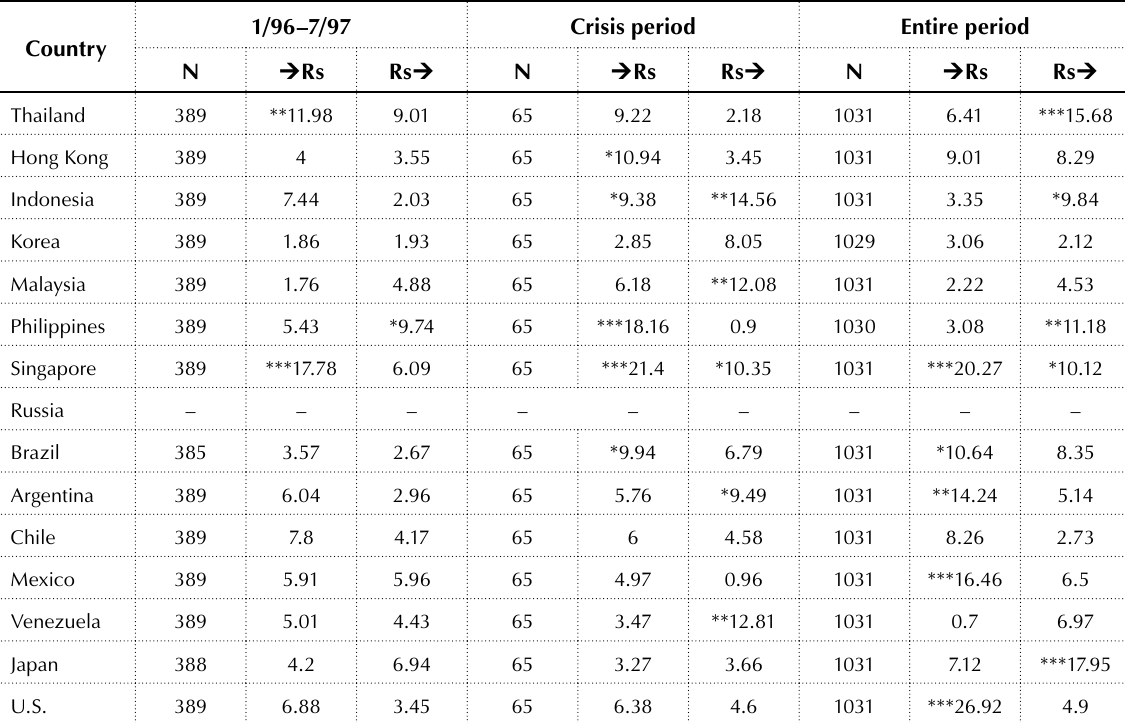
Table 4 . Liquidity contagion after the Russian crisis 1/96–7/97 Crisis period Entire period Country